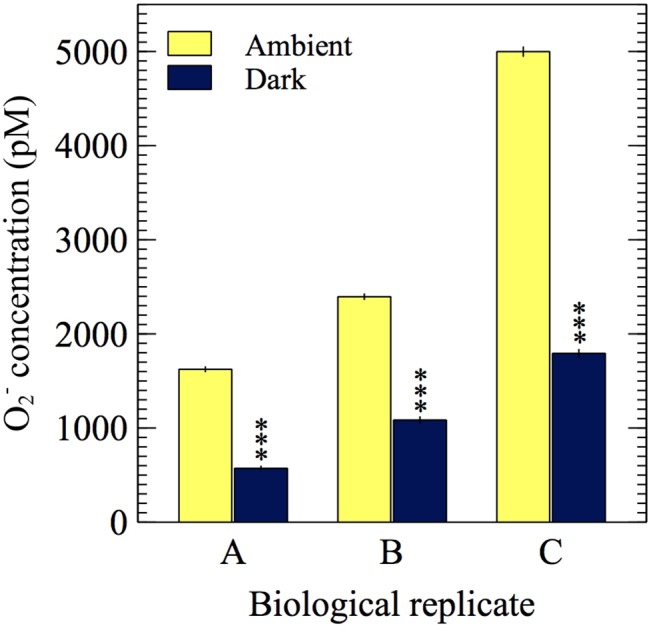
O2− measurements from three biological replicates of E. huxleyi in the presence of ambient light (~5 μmol photons m−2 s−1) and in the dark (0 μmol photons m−2 s−1). Asterisks show significant difference (p < 0.0001) between the average dark and average ambient light steady-state O2− concentration for each biological replicate. Error bars represent one standard error of the mean (n ≥ 31 chemiluminescent counts).